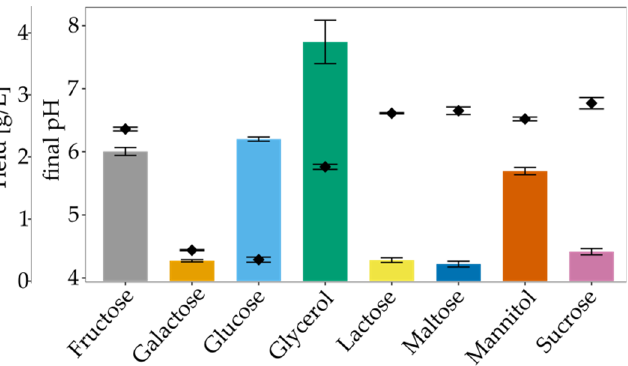
Figure 4. The yield of BNC and final pH in media modified with different carbon sources. Bars represent yield and points pH. Error bars represent standard deviation.